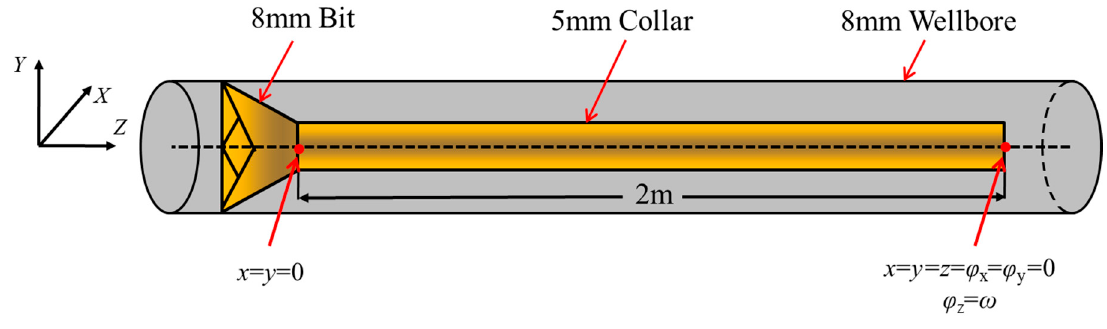
Figure 6. Research object of numerical simulation and experiment. Table 5. Detailed parameters used in numerical simulation and experiment.